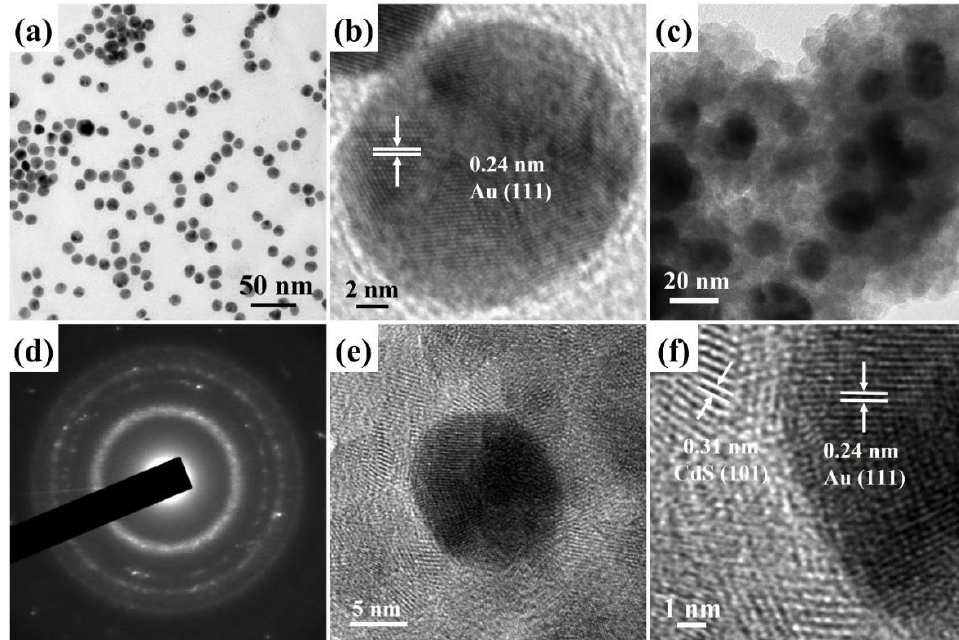
Figure 4. ( a ) TEM and ( b ) HRTEM images of Au NPs. ( c ) FETEM, ( d ) SAED, and ( e , f ) HRTEM images of Au@CdS nanocomposites.